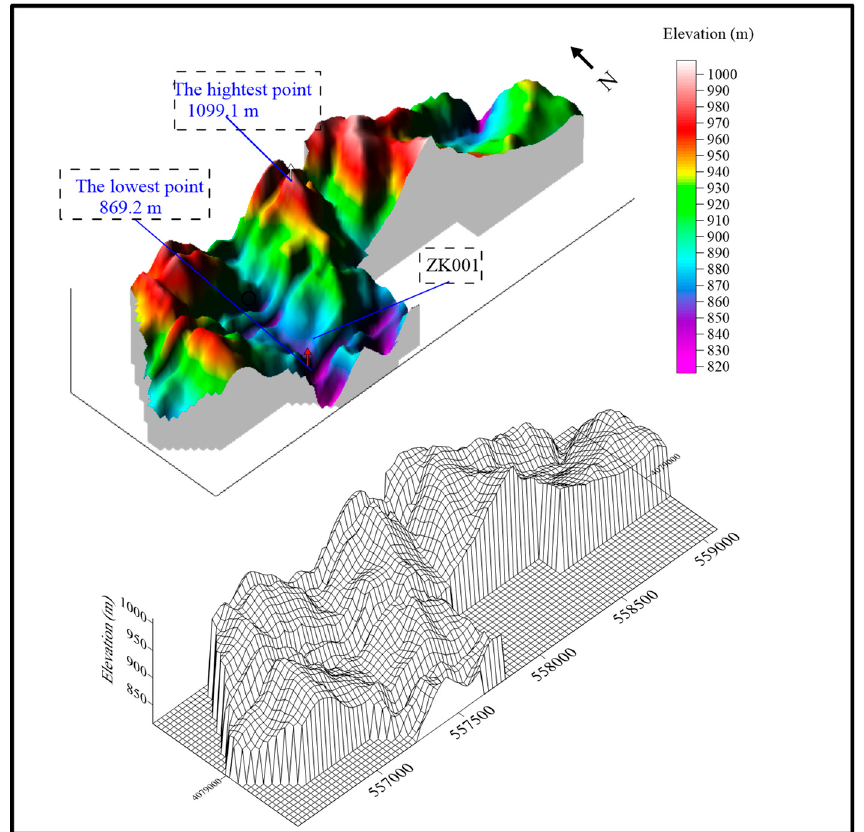
Figure 3. Topographic map of the survey area.